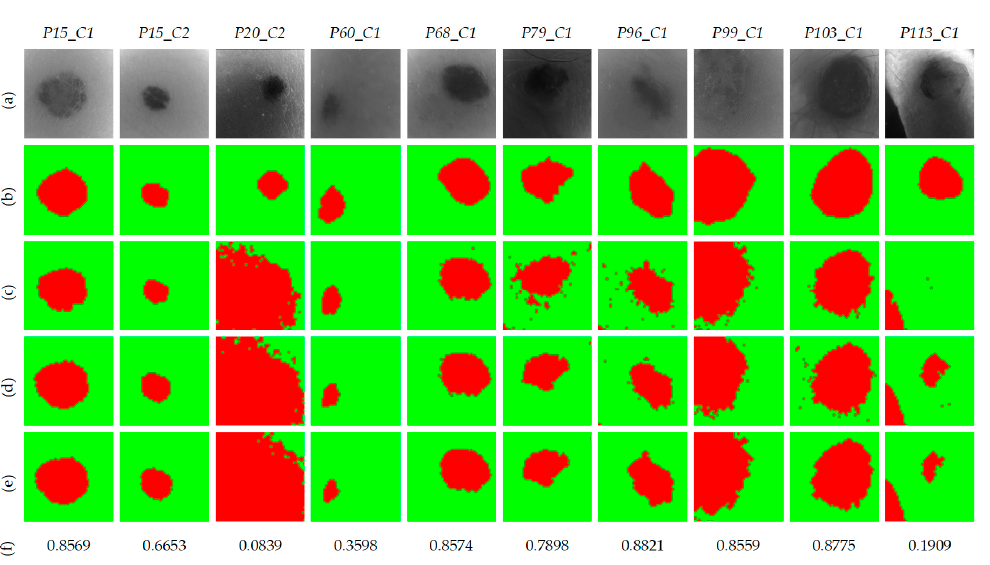
Figure 12. Two-class segmentation maps of the validation database using the per pixel method. ( a ) Gray-scale images. ( b ) Ground-truth maps. ( c ) Results with 𝐾 = 3 . ( d ) Results with 𝐾 = 7 . ( e ) Results with 𝐾 = 7 and morphological post-processing. ( f ) Jaccard coefficient values of the results with 𝐾 = 7 and morphological post-processing.